Question: Express in one sentence what the figure is showing.
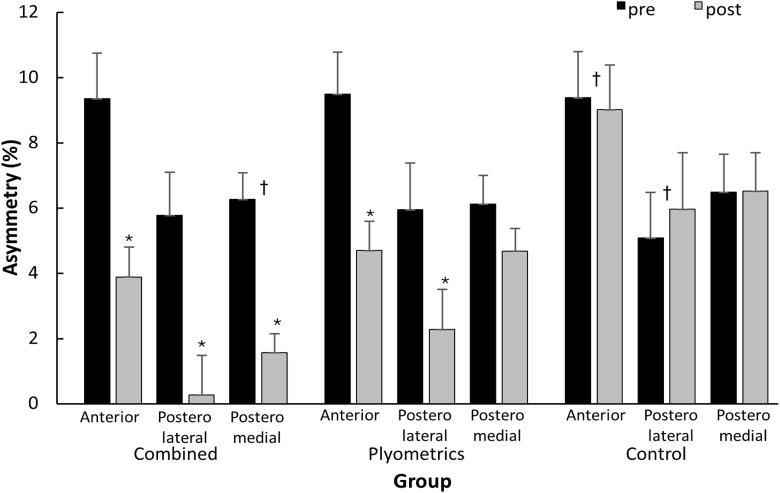
Answer: Mean (95% CI) asymmetry between legs in the three different directions at pre and posttest for each group. * indicates a significant difference with the pretest. † Indicates a significant difference with the other two groups from pre- to post test.